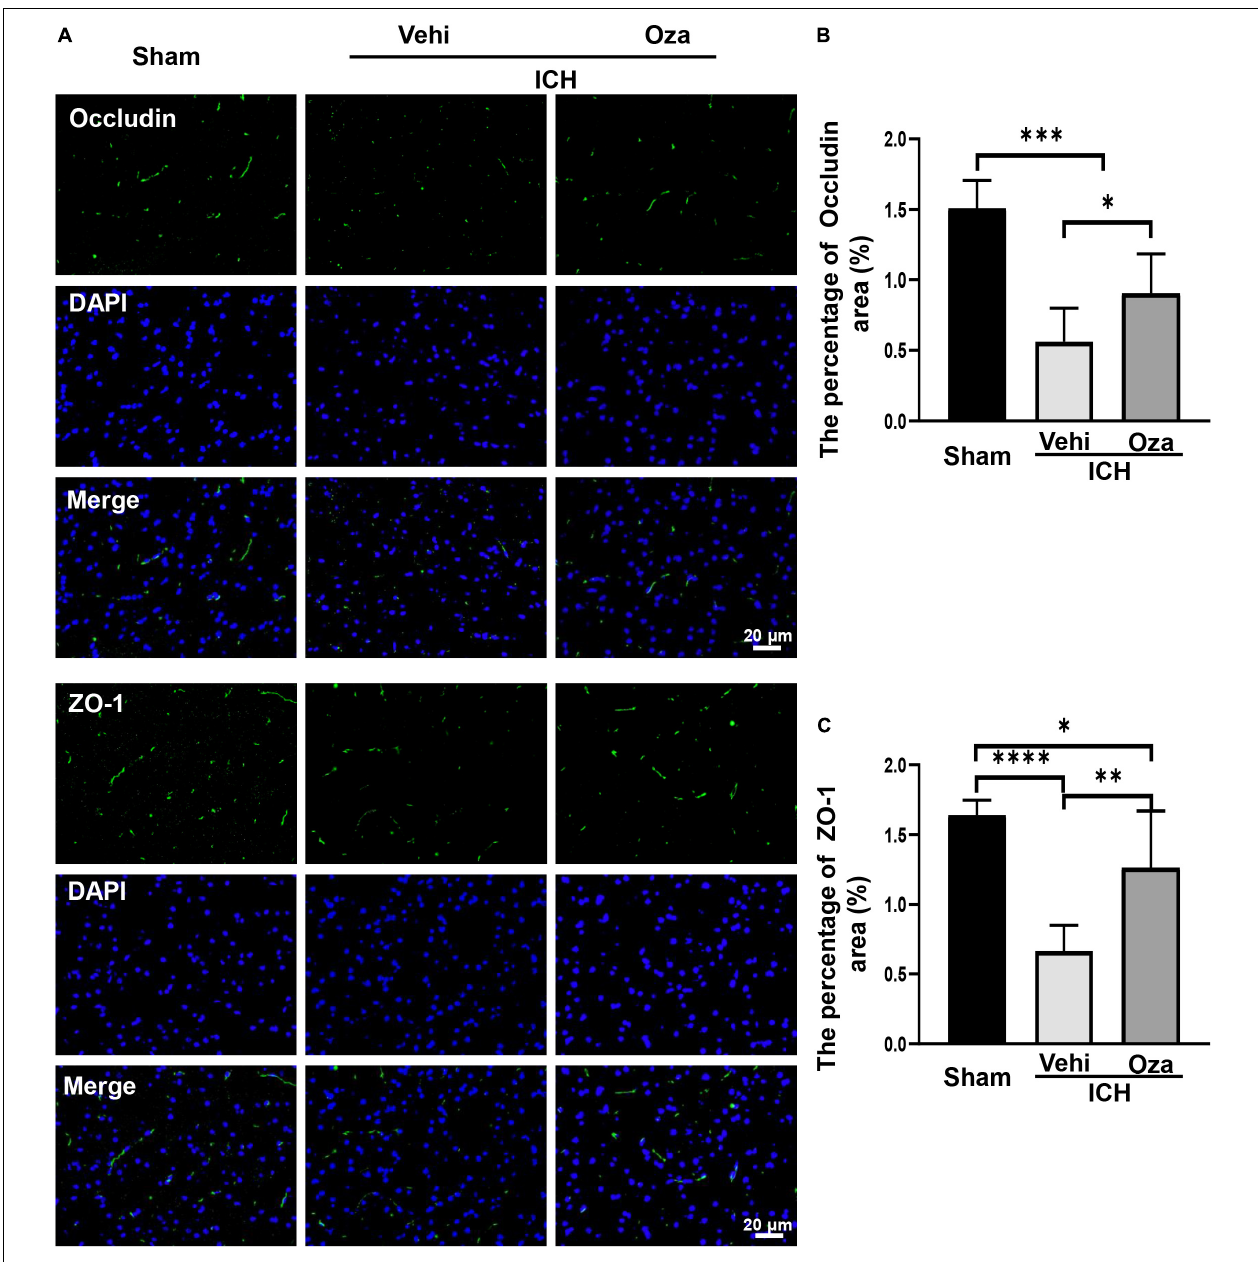
FIGURE 5 | The effects of Ozanimod on inhibition of the expression of Occludin and ZO-1 at 3 days after ICH. (A) Immunofluorescence staining (green) of tight junction associated proteins (Occludin and ZO-1). DAPI (blue) was used to label nucleus. (B,C) Statistical analysis of positive area of Occludin and ZO-1 protein. Data are presented as mean ± SD ( n = 6). Bar = 20 µ m. ∗ p < 0.05, ∗∗ p < 0.01, ∗∗∗ p < 0.001, ∗∗∗∗ p <